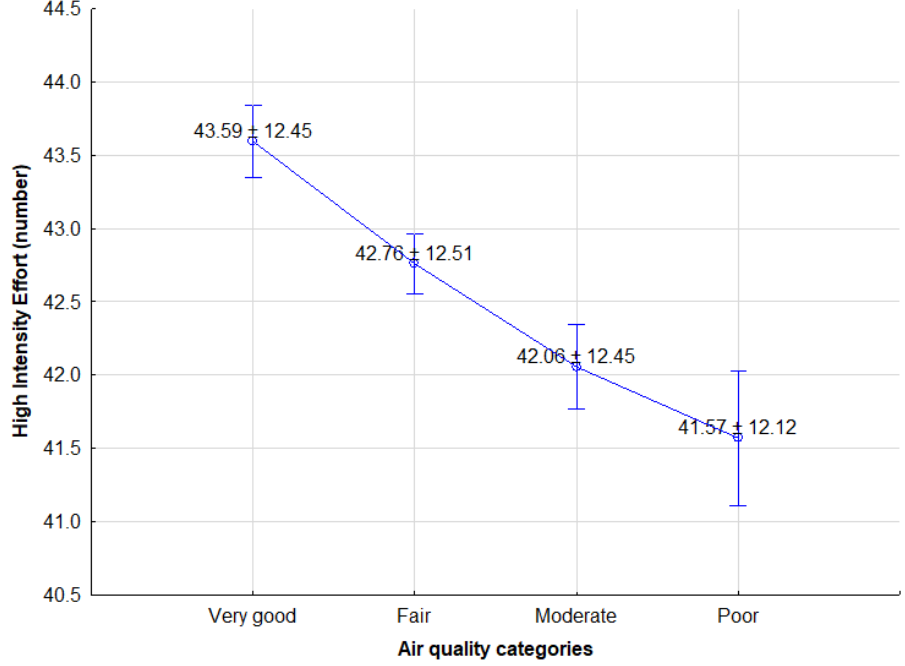
Figure 2. Differences in high-intensity effort of soccer players in relation to changes in air quality categories (mean ± SE). Differences statistically significant between very good vs. fair p = 0.01 and fair vs. moderate p = 0.05 (Source: own elaboration).